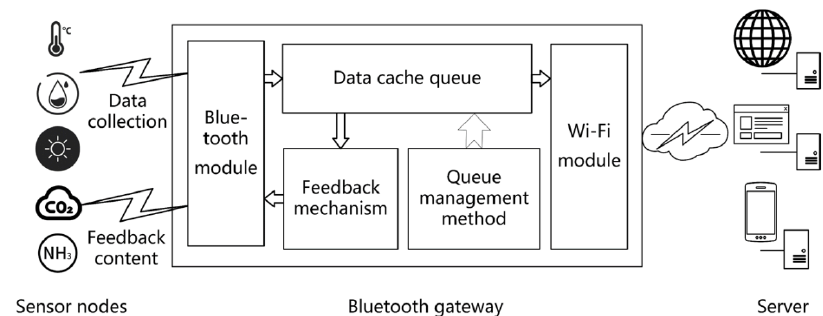
Figure 1. The overall architecture of the Bluetooth gateway system.